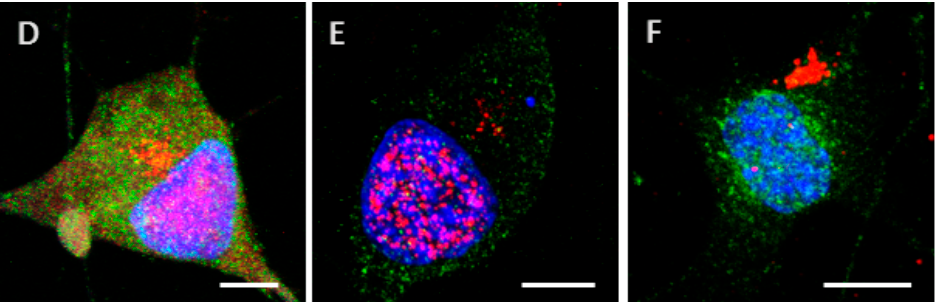
Figure A1. Internalization and processing of the Tau protein (15 µ g; A – C ) and its highly phosphorylated form (1.5 µ g; D – F ) by Neuro2A cells. Following 24 h ( A , D ), or 48 h ( B , E ) of incubation with protein, cells were immunostained with a mouse anti-His-tag antibody targeted by an AlexaFluor ® 594 antibody (red) and a rabbit anti-MAP2 antibody targeted by an AlexaFluor ® 488 antibody (green). In other experiments, cells were placed in contact with protein for 8 h, whereupon the medium was replaced by one devoid of protein and maintained for 48 h ( C , F ). Nuclei were stained with DAPI. Different digital zooms were applied to the 60 × optical zoom: A: no zoom, B: 1.2 × , C: 2 × , D: 1.6 × , E: 2.1 × , F: 2.3 × . All scale bars correspond to 5 µ m. Biomolecules 2016 , 6 , 36